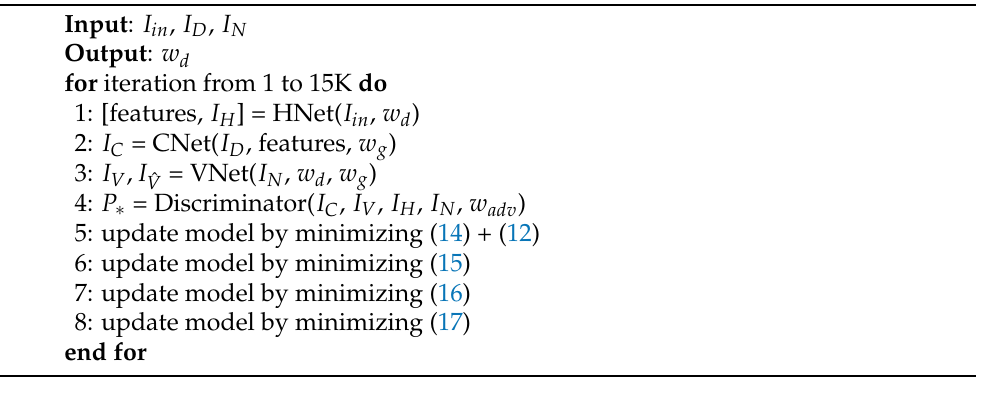
Algorithm 1: Training procedures of the proposed DVNet